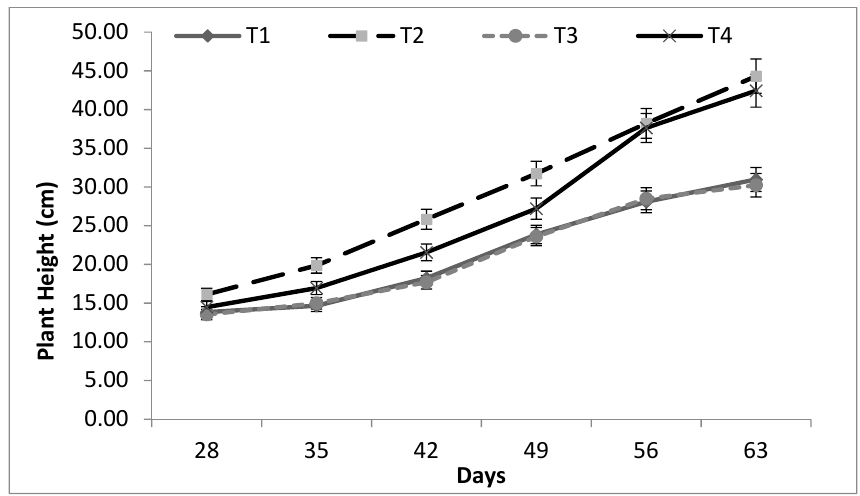
Figure 2. Height of pepper plants under different treatments at different 63 days. T1: no mulch + 251 mm of water; T2: with mulch + 251 mm of water; T3 no mulch + 129 mm of water; T4: with mulch + 129 mm of water. Table 4. Analysis of variance for factor and regression interactions of height, flowers/plant and